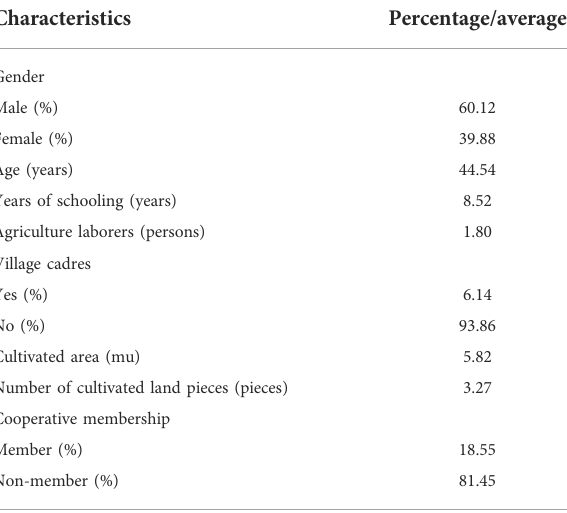
TABLE 1 Descriptive statistics of the characteristics of